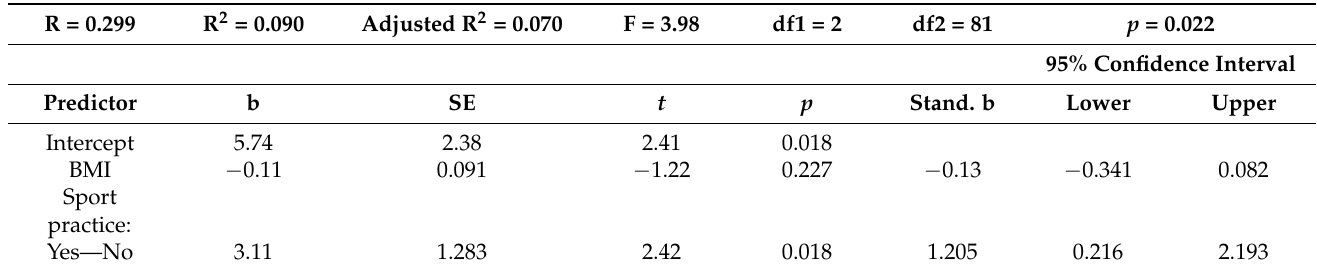
Table 4. Determinants of 20-m Shuttle Run performance in boys according to multiple linear regres- sion analysis.